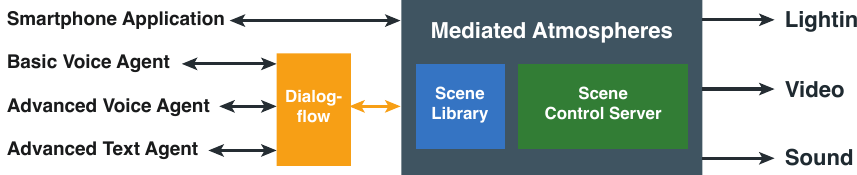
Figure 2. Top-level description of agent integration into Mediated Atmospheres .